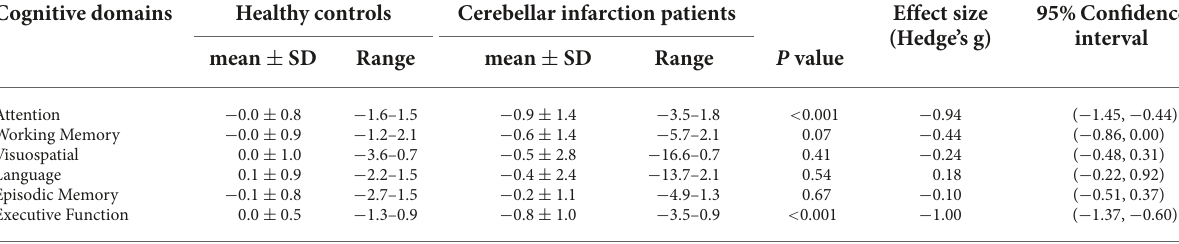
TABLE 2 z -Transformed cognitive scores in healthy controls and cerebellar infarction patients. Cognitive